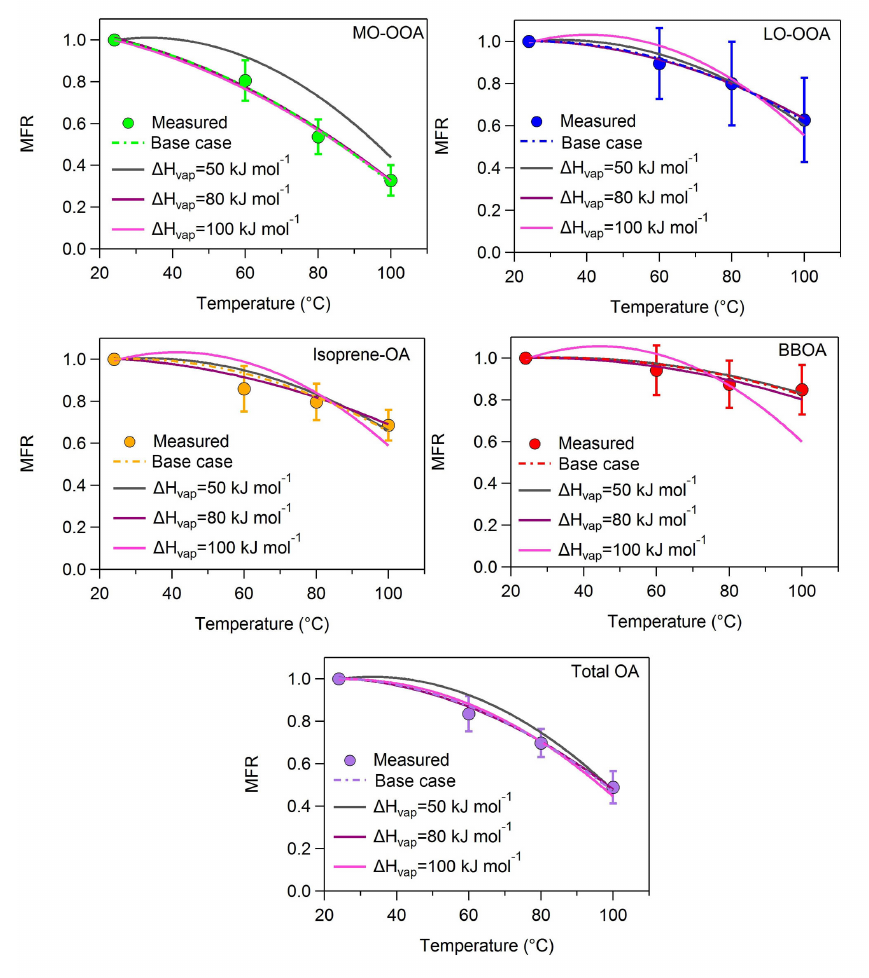
Figure A1. MFRs of the loss-corrected PMF OA factors and total OA for fixed values of the vaporization enthalpy. The circles denote the measurements with the 1 standard deviation of the mean, the dash lines correspond to the base case, the grey lines represent the case of a constant (cid:49)H vap of 50kJmol − 1 , the magenta lines stand for the case of a constant (cid:49)H vap of 80kJmol − 1 and the pink lines correspond to the case of a constant (cid:49)H vap of 100kJmol − 1